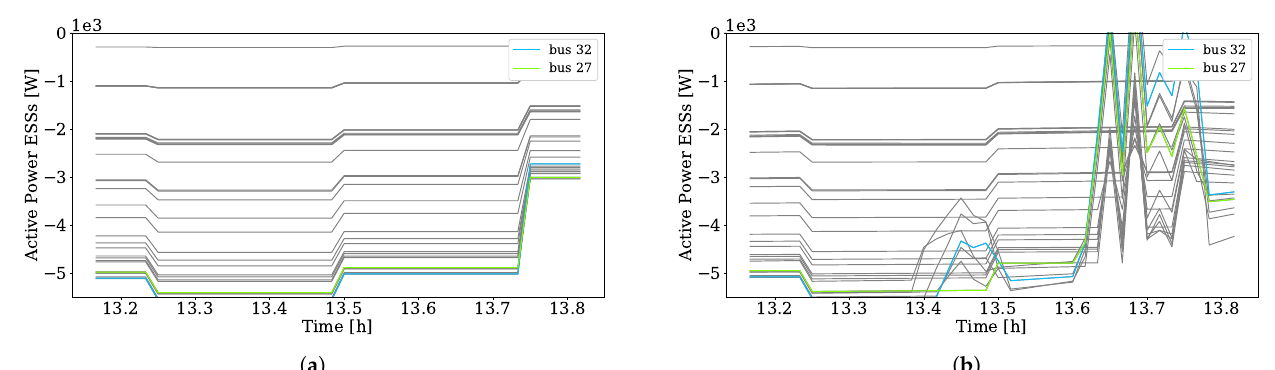
Figure 18. Results without the online control 3. ( a ) Active power ESSs with no online control applied; ( b ) active power ESSs with online control.